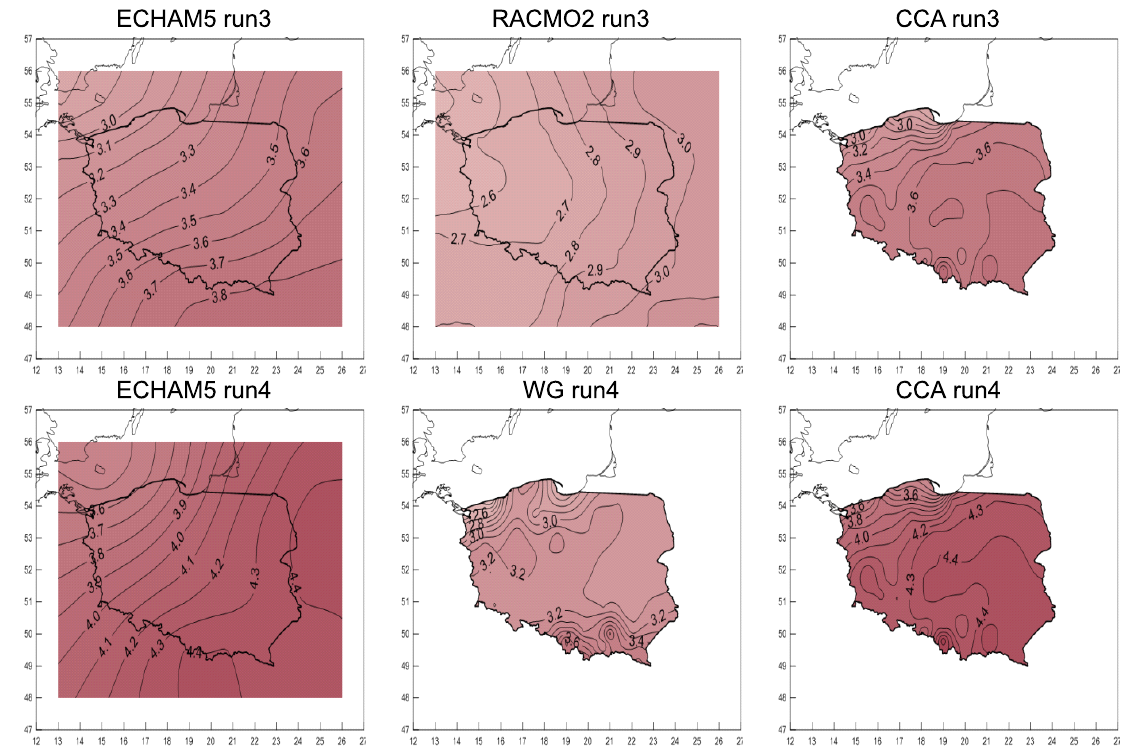
Fig. 12. Anomalies of air temperature (°C) in the autumn season (SON) 2071–2090 in relation to reference period (1971–2000) in Poland based on A1B emission scenario for models: ECHAM5 run 3and 4, RACMO2 run 3, CCA run 3 and 4, WG run